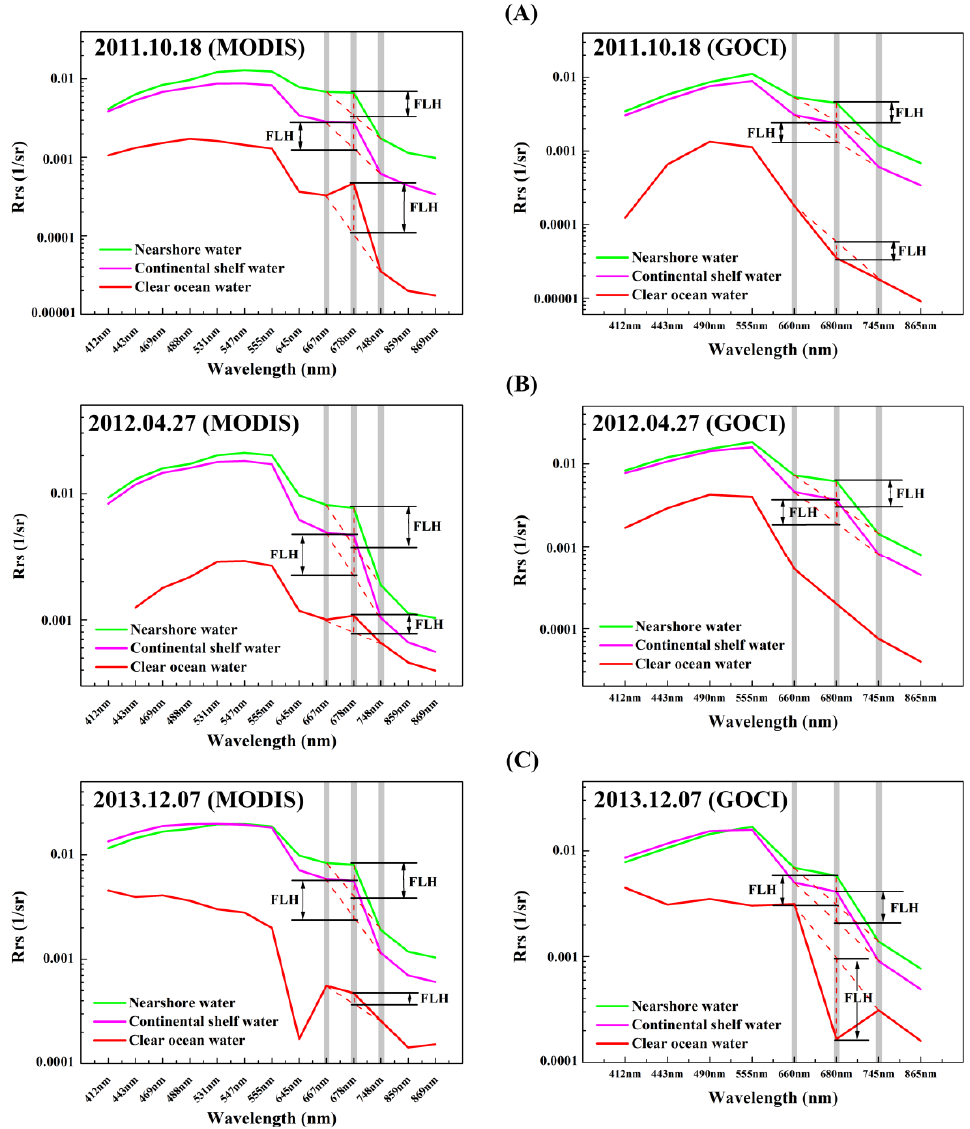
Figure 3. Variation in the average Rrs values of different water bodies in different bands for observation dates of ( A ) 18 October 2011, ( B ) 27 April 2012, and ( C ) 7 December 2013. The left sides show the MODIS curves, where the gray histograms denote the three fluorescence bands of MODIS (667, 678, and 748 nm); the right sides show the GOCI curves, where the gray histograms denote the three fluorescence bands of GOCI (660, 680, and 745 nm).